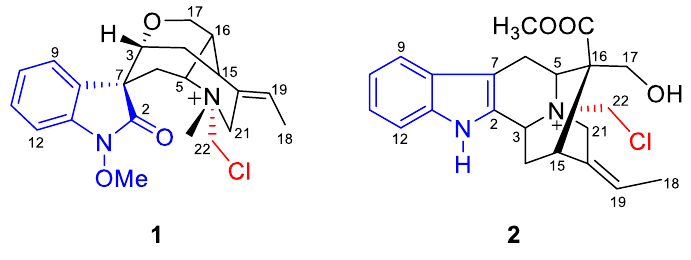
Figure 1. Structures of compounds 1 – 2 .